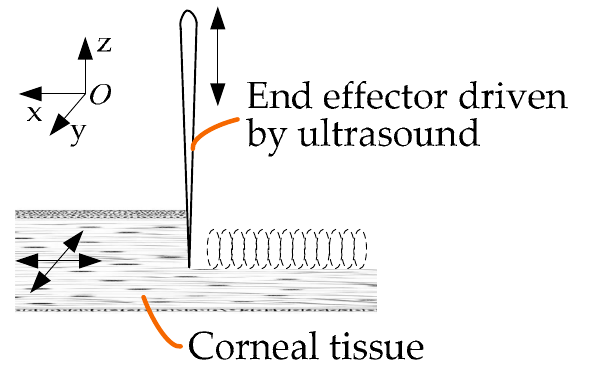
Figure 5. Schematic diagram of ultrasound-assisted corneal trephination with a microscopic per- spective.